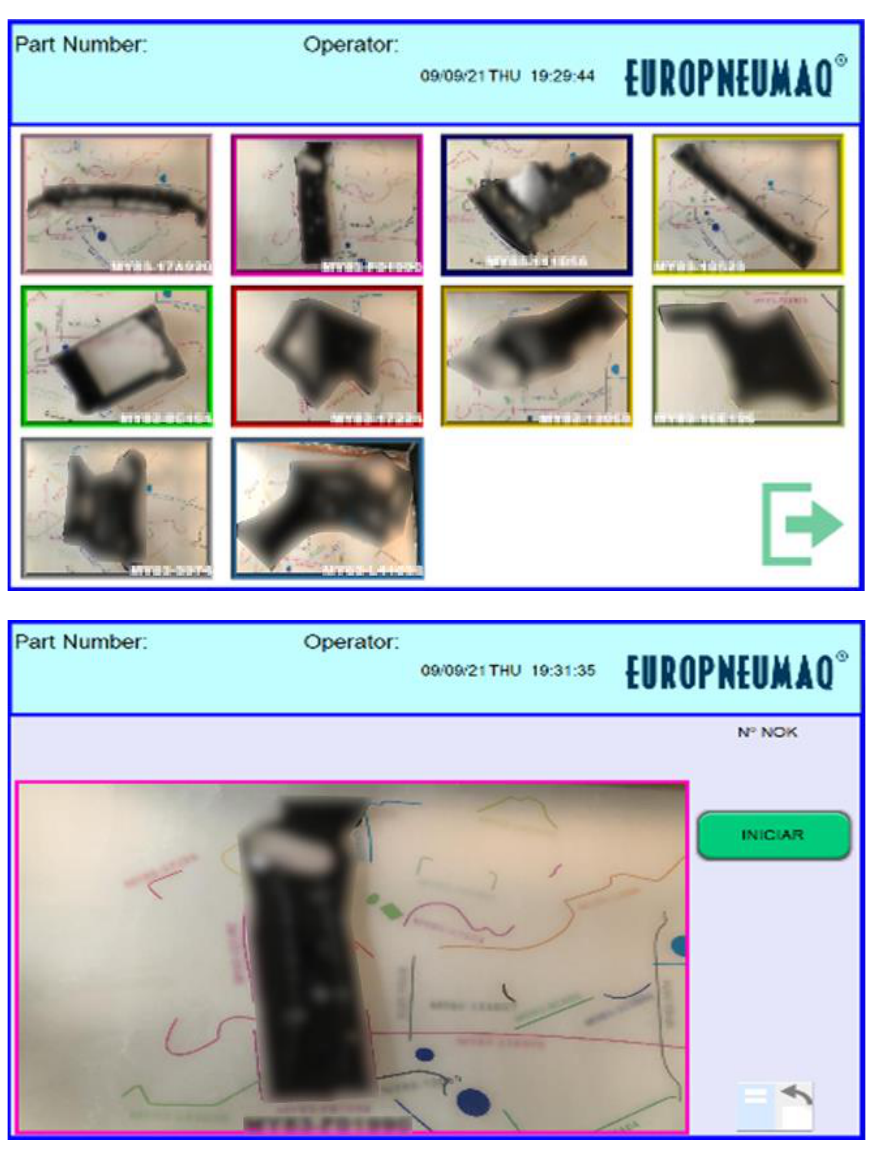
Figure 3. Position and orientation of the objects.